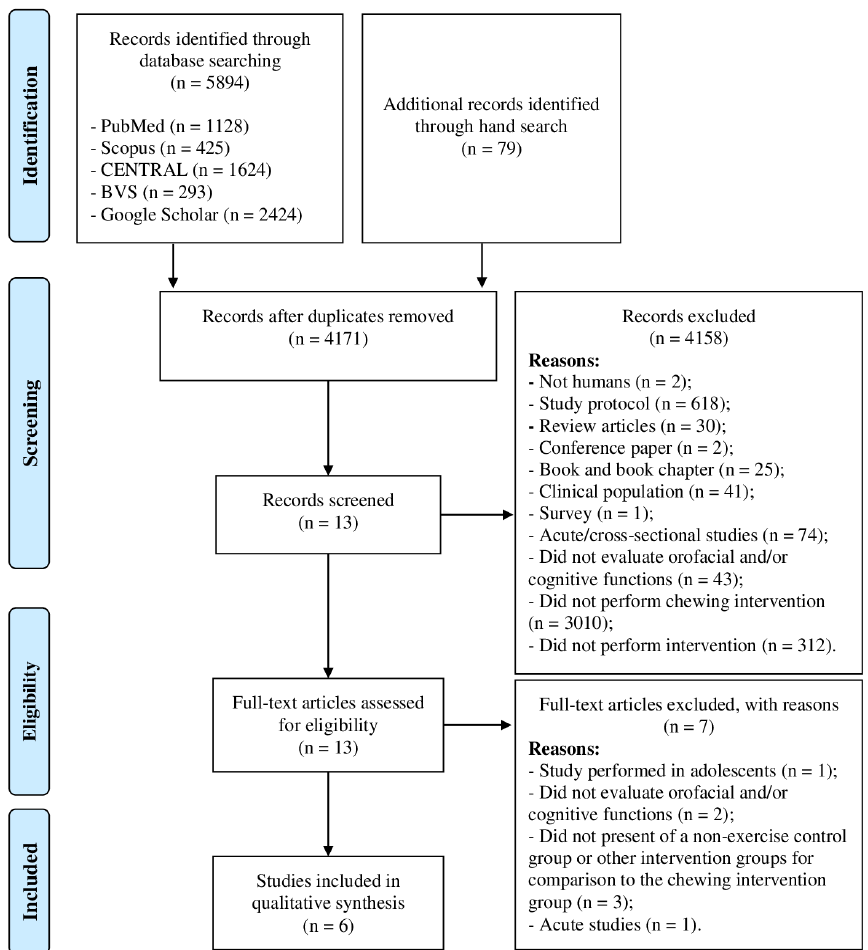
Figure 1. Diagram flow of outcomes of review.